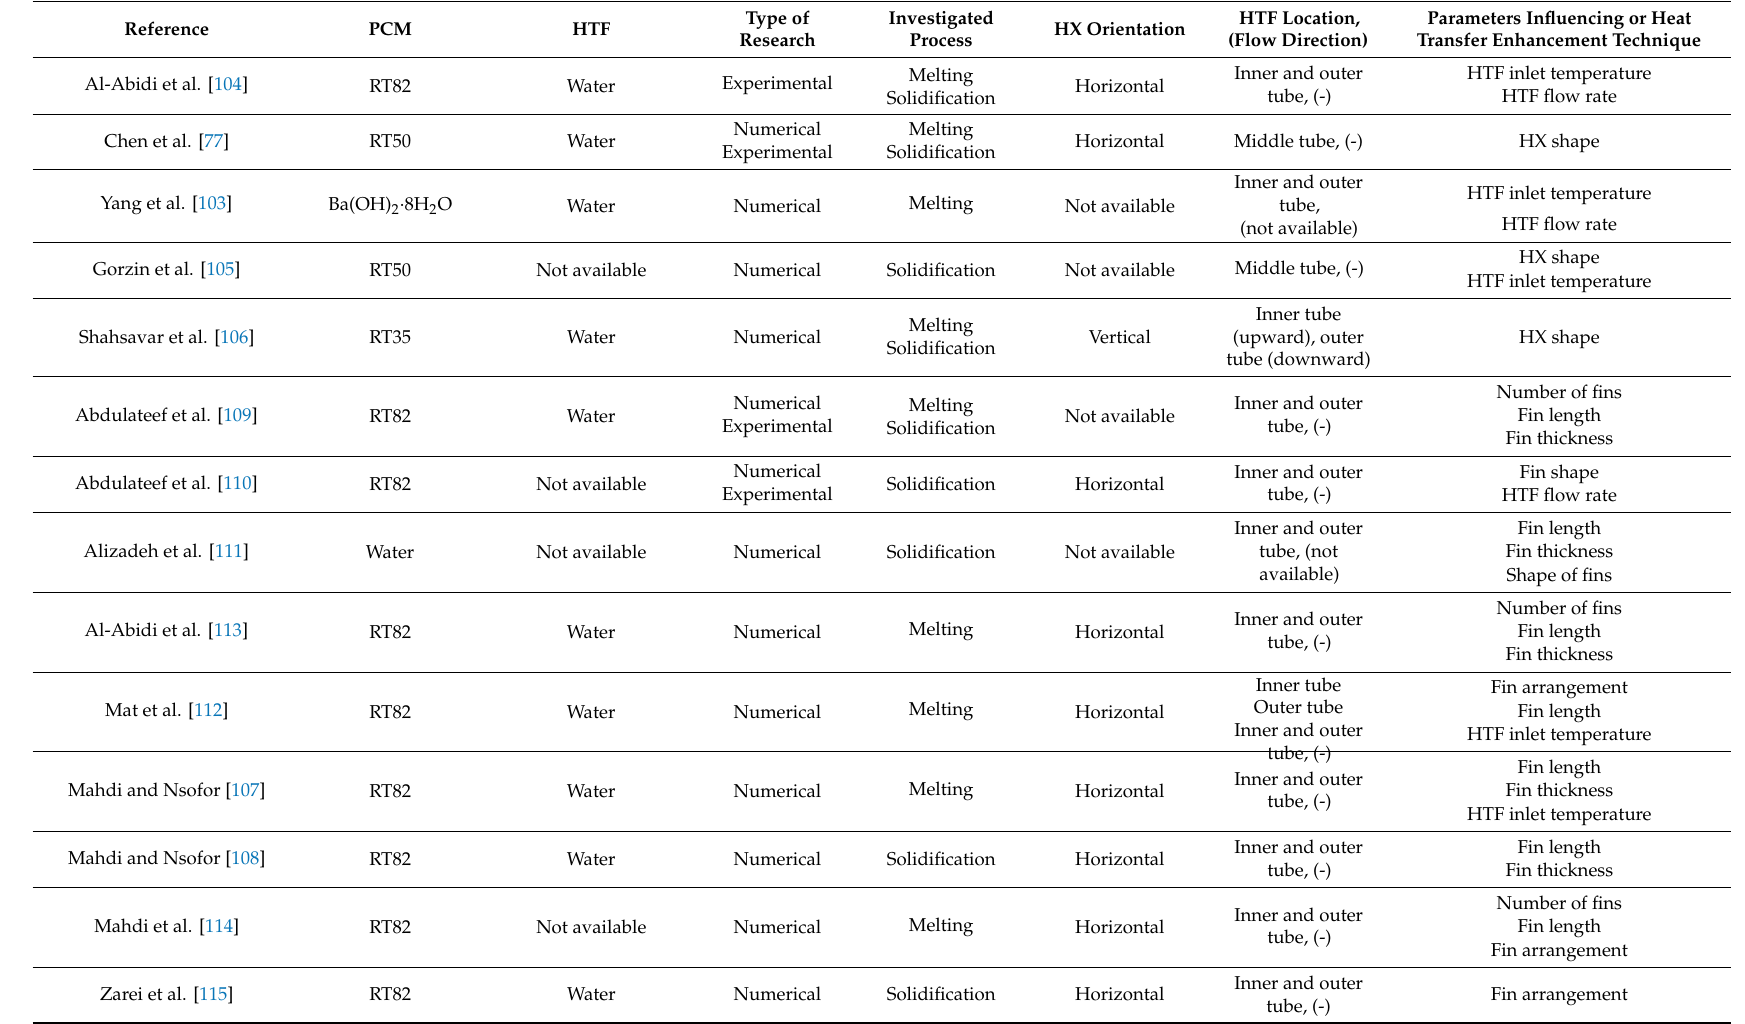
Table 5. Research on the triple-tube heat